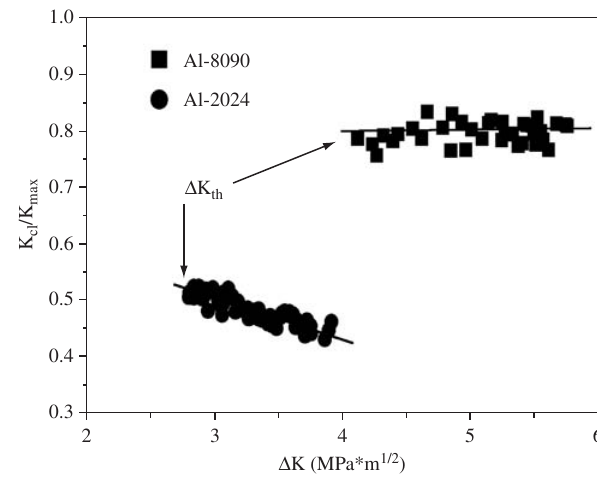
Figure 5. Variation of crack closure with stress-intensity-factor range.